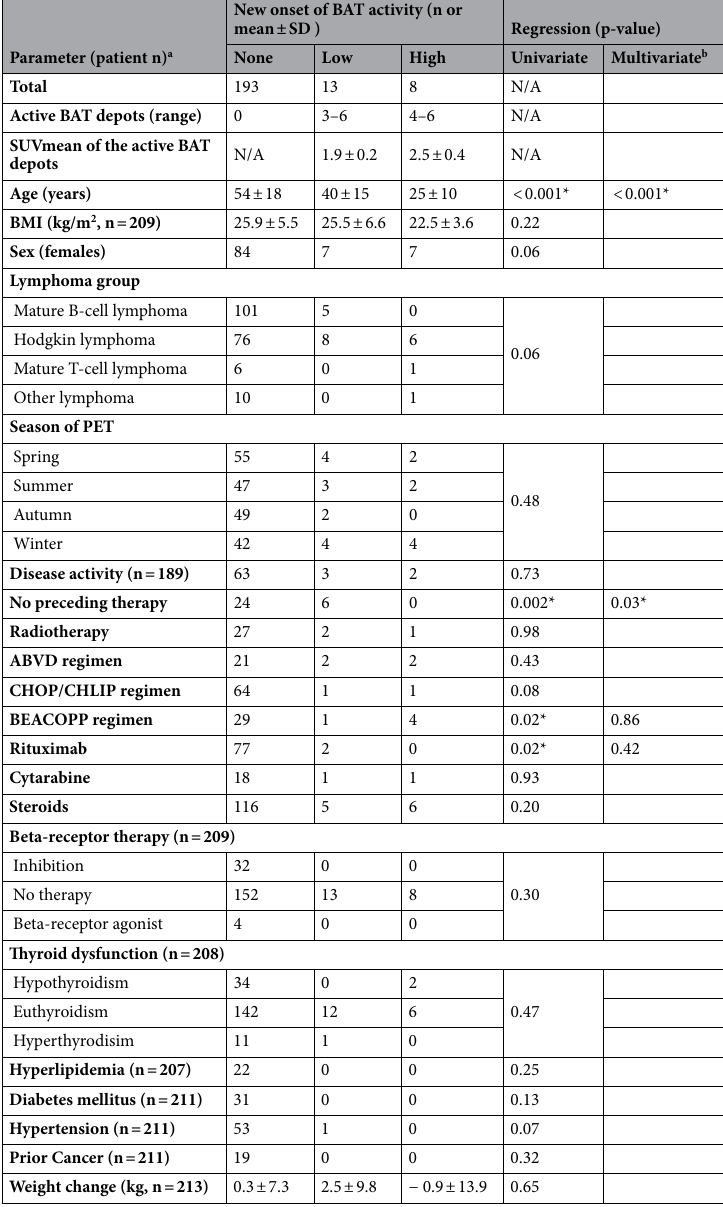
amount of weight change between the first and second PET/CT examination was not linked with the incidence of BAT activity.